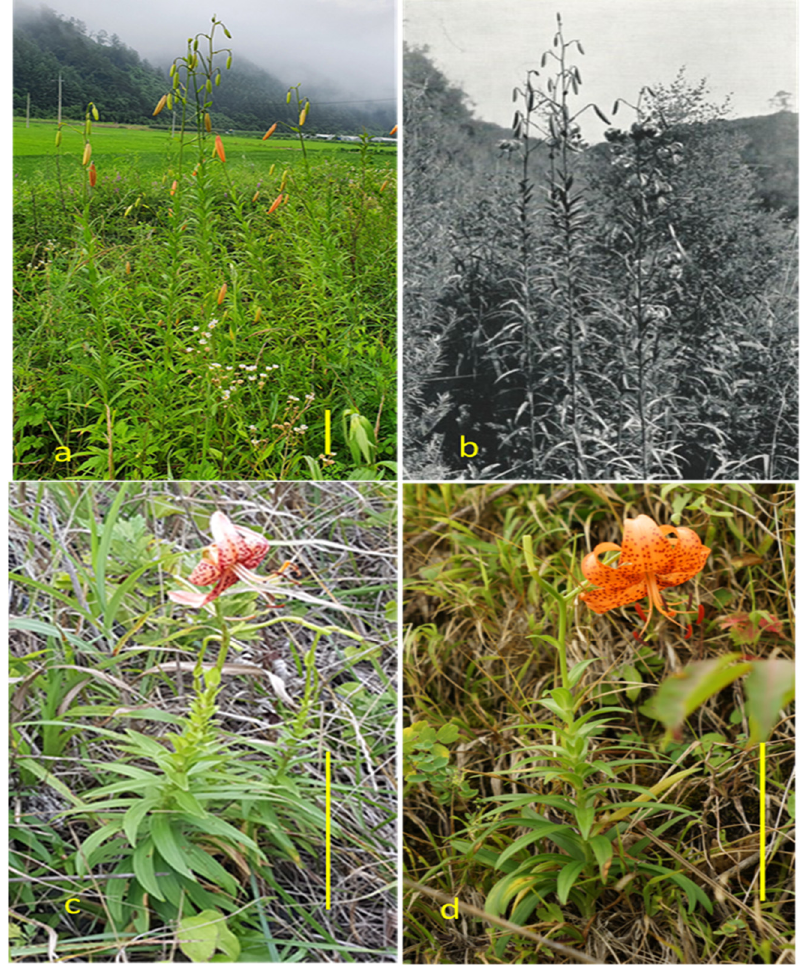
Figure 2. L. leichtlinii morphology in native habitats in Korea and Japan. ( a ). Wonju, Kangwon-do, Korea. ( b ). North Korea [27]. ( c ). Ishiji, Niigata, Japan. ( d ). Ikistuki, Hirado, Japan. Bars indicate 20 cm. Table 3. Comparison of qualitative traits between JSW and KR L. leichtlinii (N = 59). Trait JSW KR Anther color Greyed red 182B